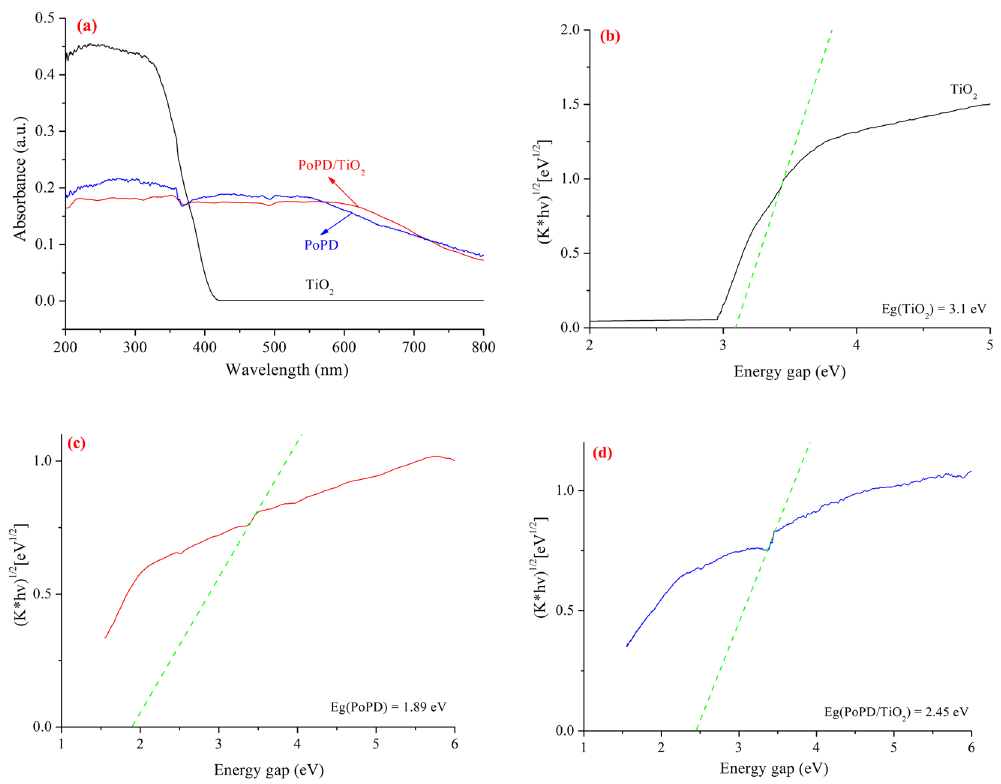
Figure 7. ( a ) UV-Vis DRS spectra of samples and energy gap of ( b ) TiO 2 , ( c ) PoPD, and ( d ) P/T(1/4).